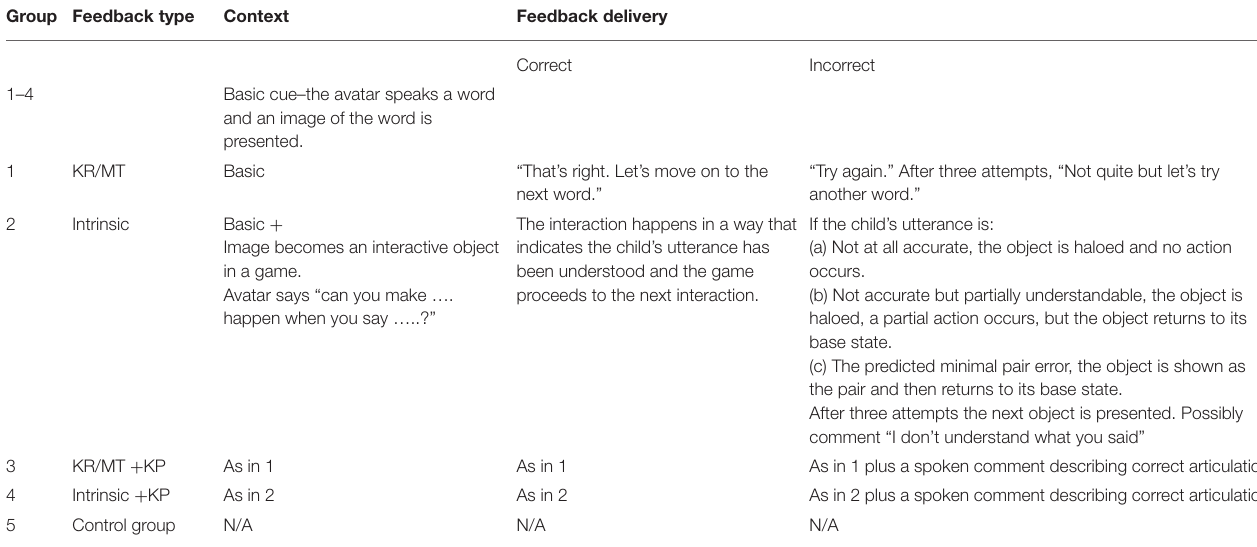
TABLE 4 | Context of presentation and feedback delivery for each